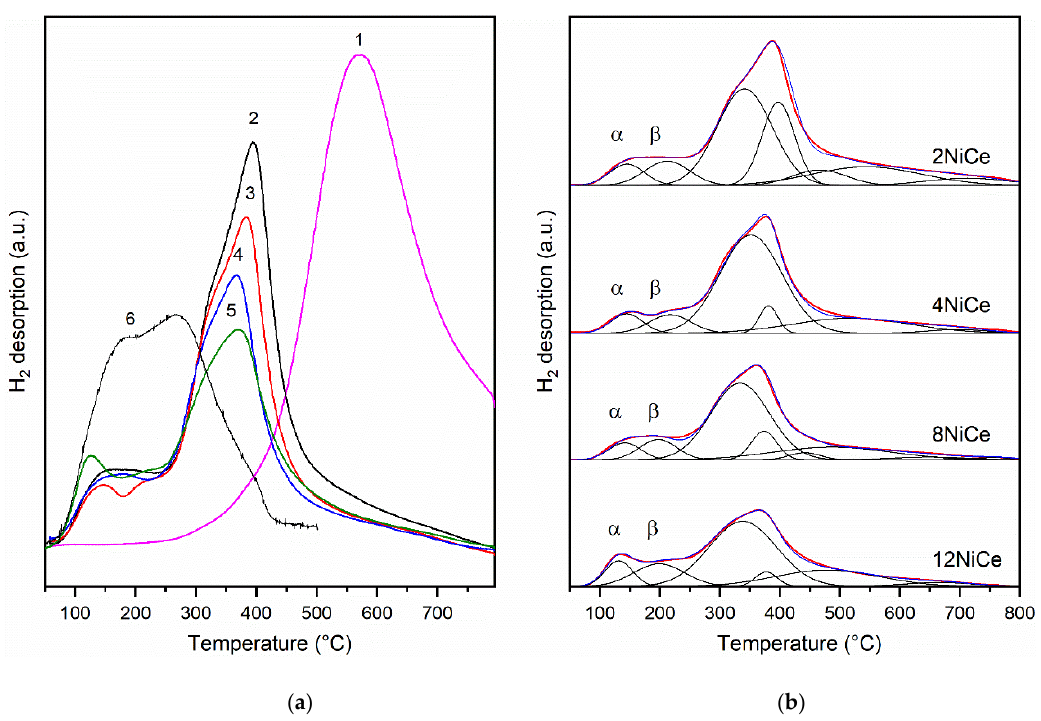
Figure 3. ( a ) H 2 -temperature programmed desorption (H 2 -TPD) profiles of samples reduced at 800 ◦ C: (1) r-CeO 2 ; (2) 2NiCe; (3) 4NiCe; (4) 8NiCe; (5) 12NiCe; (6) as reference: 2NiCe reduced at 500 ◦ C; ( b ) deconvolution of H 2 -TPD profiles of NiCe samples.